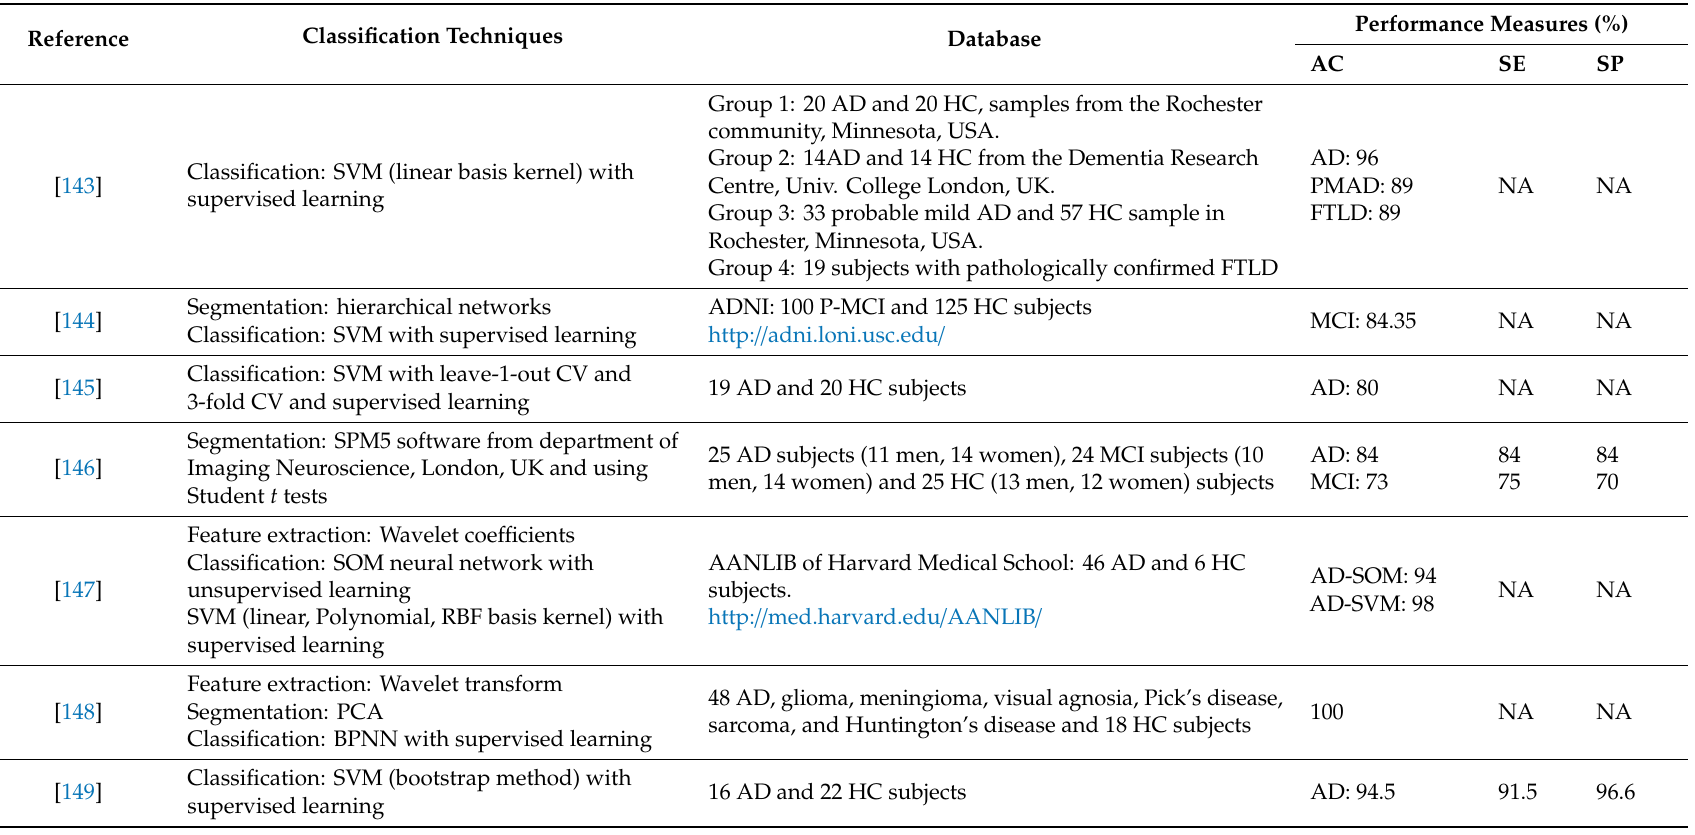
Table 3. Some works described in the literature related to the computer aided-diagnosis systems of Alzheimer’s disease through MRI. These CAD systems used classification methods based on supervised or unsupervised training. The e ffi ciency of the proposed CAD system is demonstrated by estimating the percentage of the following performance measures (last column): Sensitivity (SE) which represents the true positive rate, specificity (SP) which estimates the true negative rate and accuracy (AC) that determines the proportion of true results in the database, whether true positive or true negative. In [143], the reported learning time was around a week, while in [148] the computation time reported was 0.0451 s per